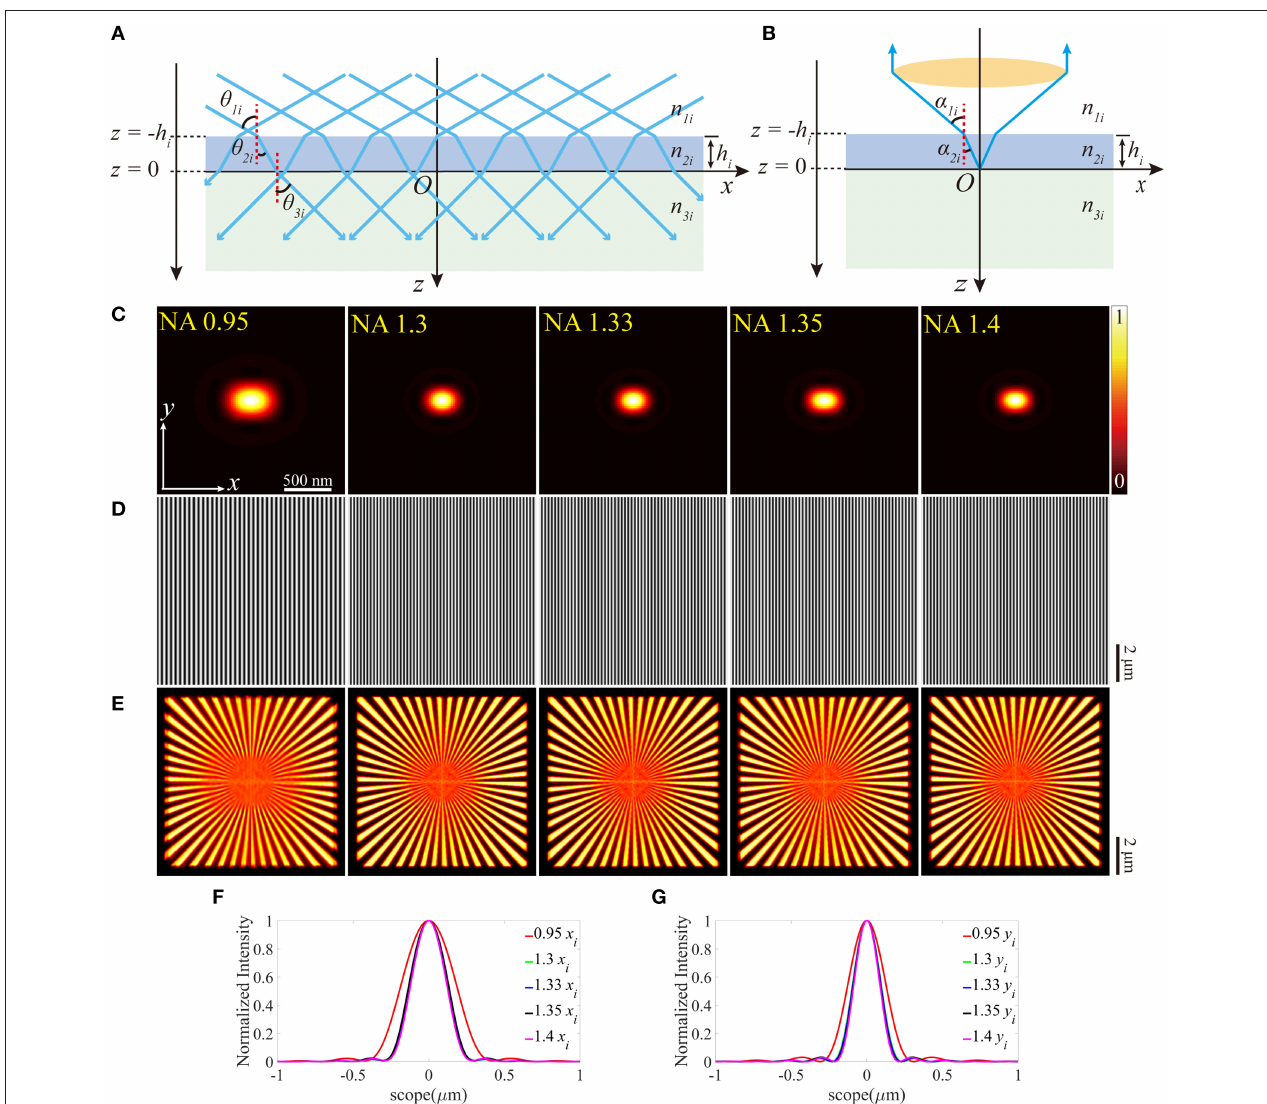
FIGURE 1 | SIM with no aberrations for objectives with different NAs. (A) The illumination beam path. (B) The fluorescence is inversely collected by the same objective using the classic epifluorescence architecture. (C) The PSFs on the plane z = 0 (ideal focal plane). (D) The excitation patterns calculated from different objectives using the same parameters in (C) . (E) The reconstructed images of SIM from the objectives with different NAs. From left to right, the resolutions are 164, 128, 125, 125, and 120nm. (F,G) are profiles of the ideal PSFs in (C) on the x and y-direction,